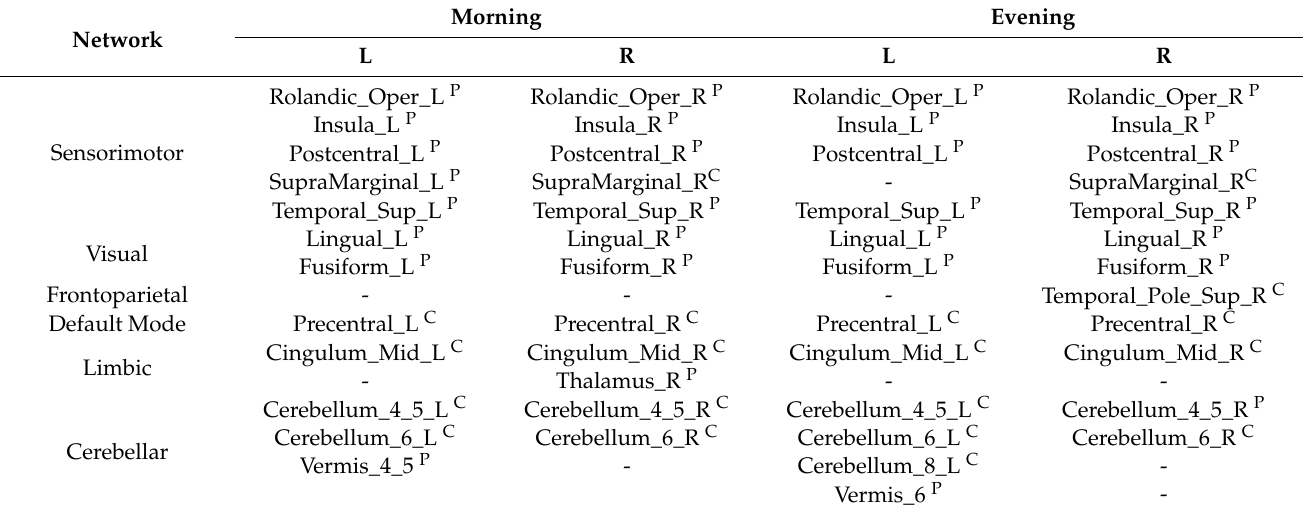
Table 3. Hub regions in different brain networks (at a sparsity of